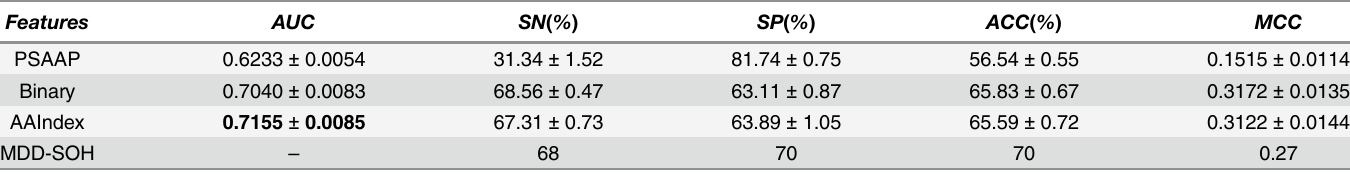
Table 3. The 10-fold cross-validation results of three different feature constructions on the balanced training dataset. The results have been run 20 times for every feature construction by SVM algorithm with g = 0.005 and cutoff = 0.5. The values are mean ± standard variance. The results of MDD-SOH were obtained in 5-fold